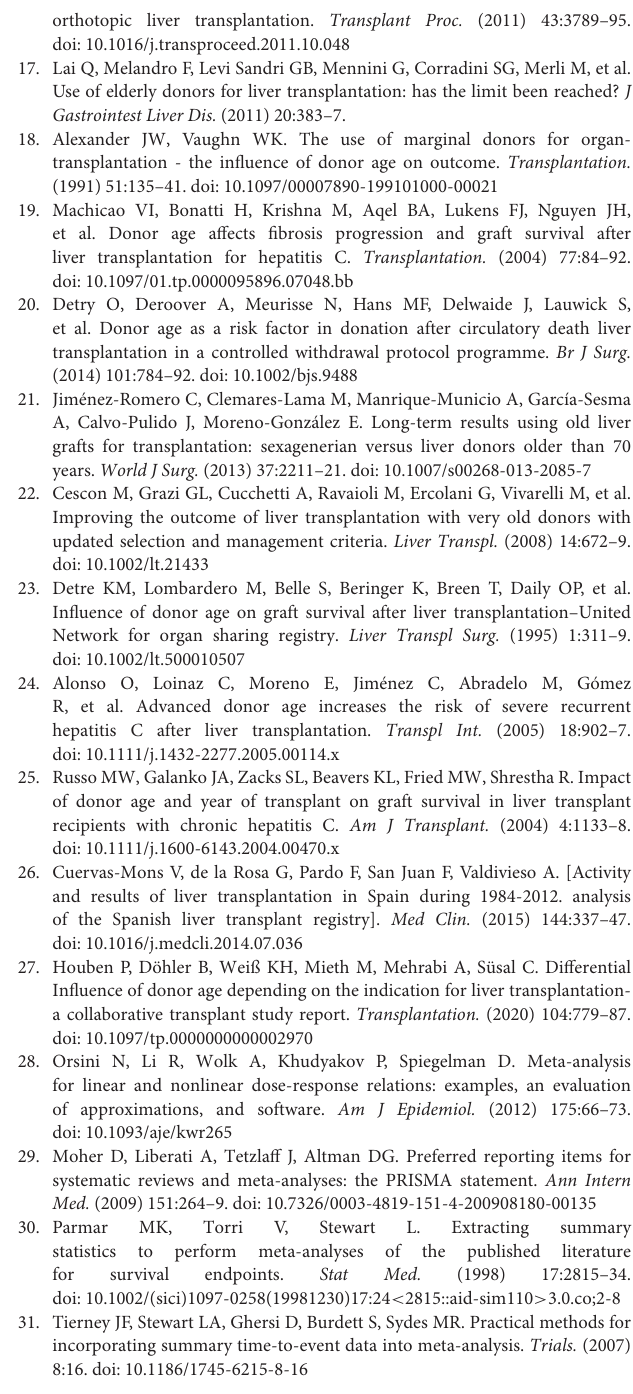
Supplementary Figure 12 | Funnel plot analysis on publication bias of continuous risks of aging on post-transplant outcomes. Risk was evaluated followed per 10-year of donor age increment. (A) Begg’s funnel plot on publication